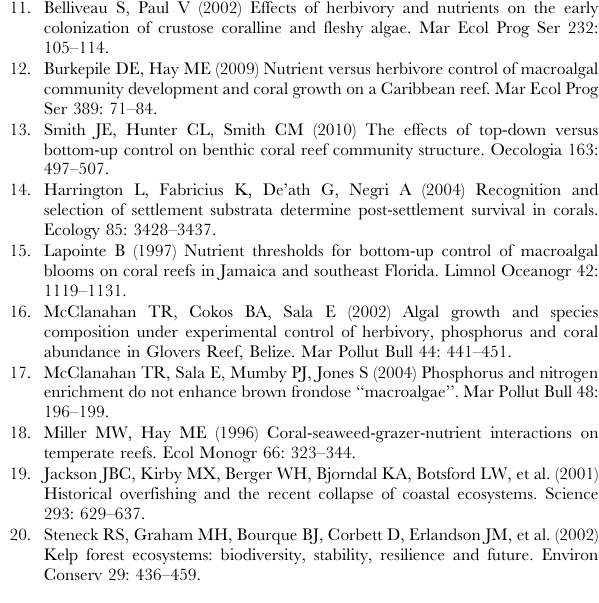
Figure S3 d 15N isotopic signatures of homogenized Table 5. Results of the 3-factorial ANOVA of O 2 consumption cover of light-exposed tiles. d 15N values (mean 6 SE) are of exposed and shaded tiles. shown for each treatment over 5 sampling times. Missing values of wk 1 and wk 4 resulted from insufficient algal material for analysis. P-values are calculated from 3-factorial ANOVA and originate Exposed Tiles Shaded Tiles from analysis across the whole study period (see Table S3 for full test results). (PDF) Table S1 List of counted herbivorous fish. Listed are families, species names, abundance (normalized to ind. m 2 2 ), and their biomass (normalized to g m 2 2 ). (DOC) Table S2 List of counted sea urchins. Listed are species names, abundance (ind. m 2 2 ), and their biomass (g m 2 2 ). – (DOC) Table S3 Results of the 3-factorial ANOVA of d15N isotopic signatures of cover from light exposed tiles. Significant results are indicated by asterisks. Abbreviations: C= Cage, F = Fertilizer, T = Time.